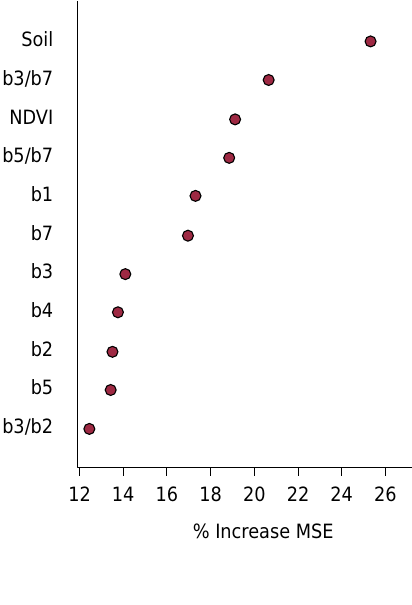
Figure 2. Importance of the predictors in models derived from the Random Forest. MSE = Mean Square Error.